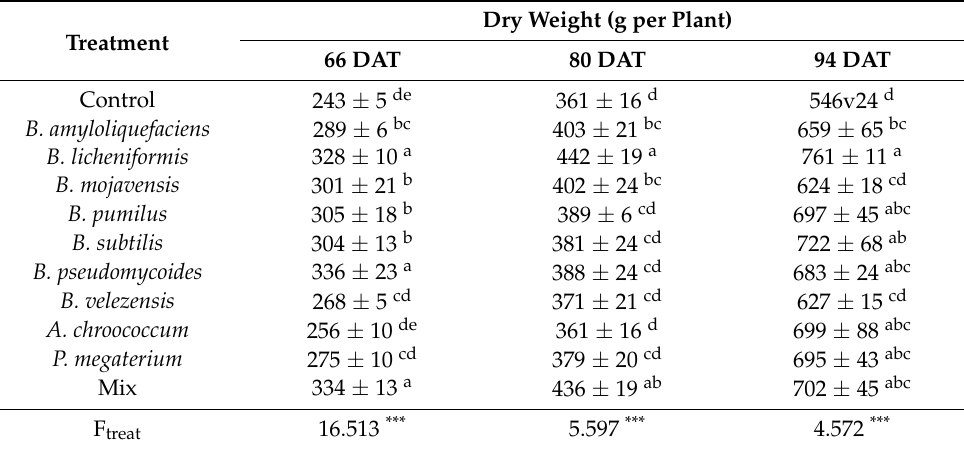
Table 3. Effect of PGPB strains on dry weight of whole plants 66, 80, and 94 DAT.